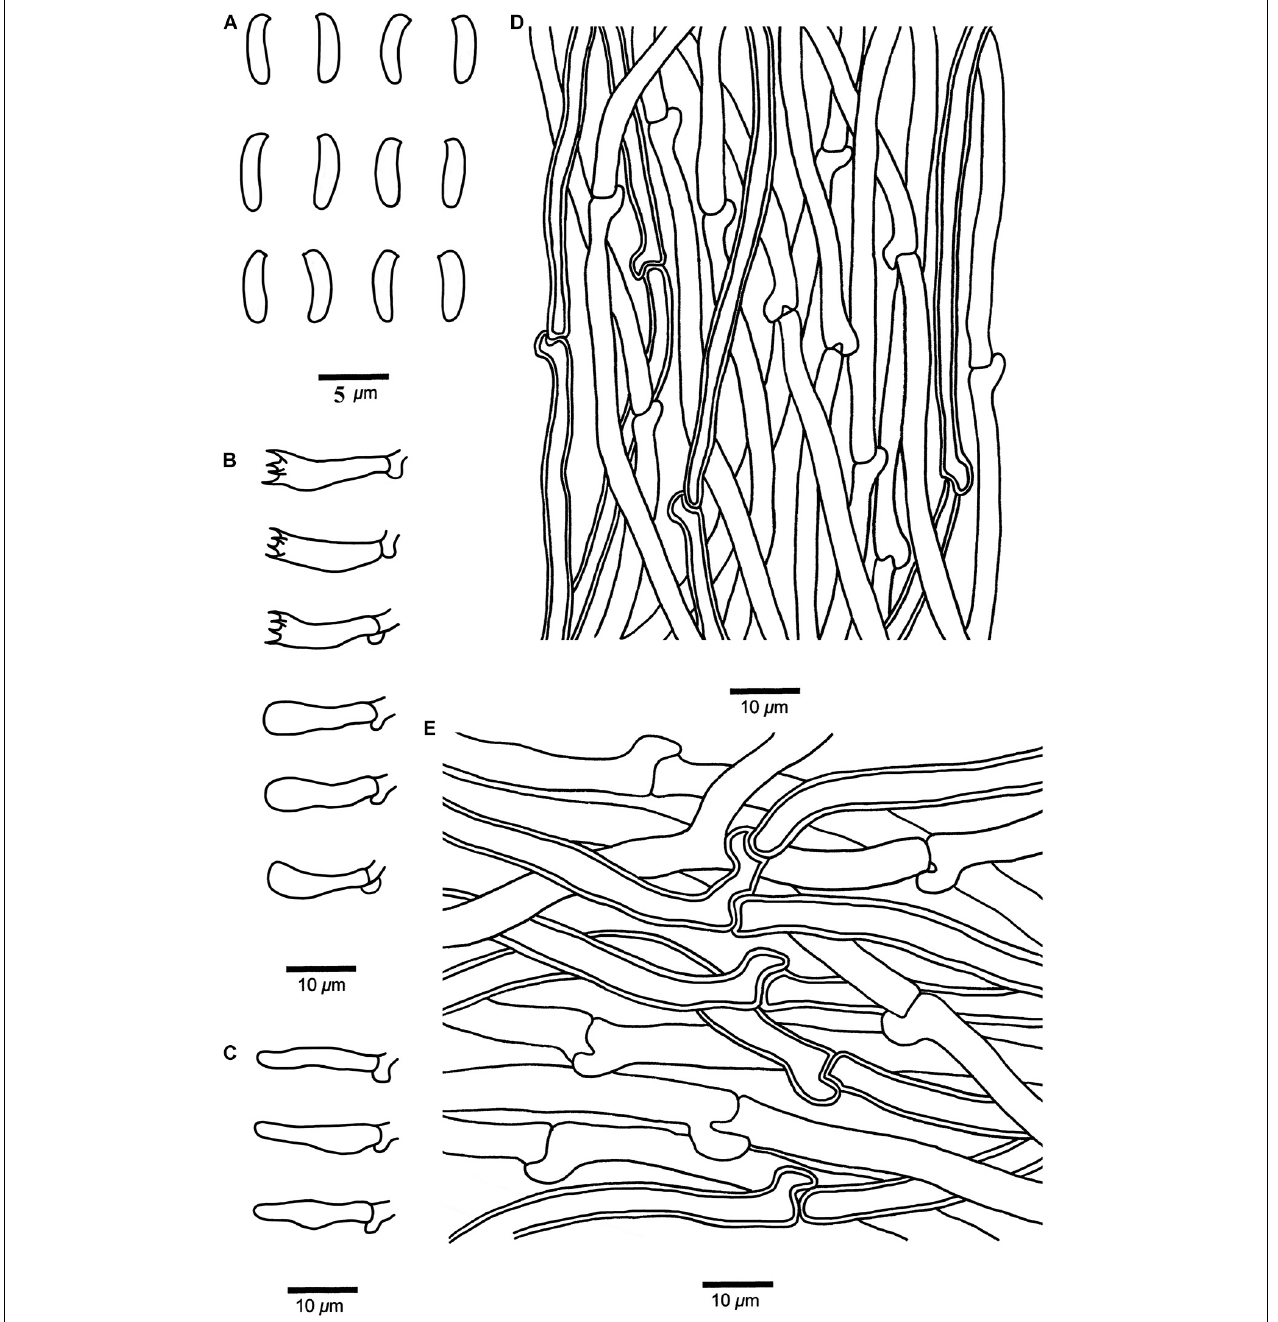
FIGURE 7 | Microscopic structures of Cyanosporus nothofagicola (drawn from the holotype). (A) Basidiospores; (B) Basidia and basidioles; (C) Cystidioles; (D) Hyphae from trama; (E) Hyphae from context. Bars: (A) = 5 µ m; (B–E) = 10 µ